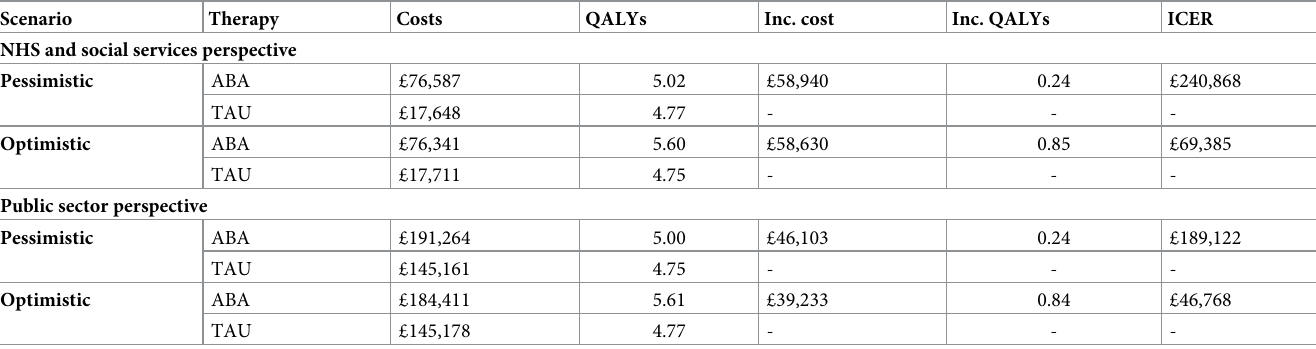
Table 4. Base-case results: Probabilistic analysis.